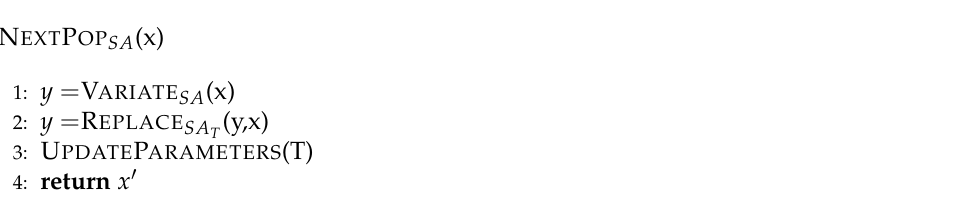
Algorithm 10 Simulated Annealing in terms of VR